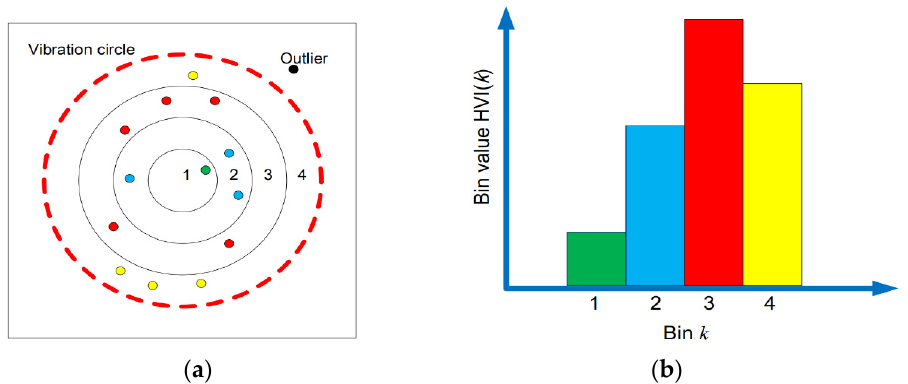
Figure 14. The diagram of HVI: ( a ) distribution of vibration points within rings and ( b ) histogram of vibration points [61].